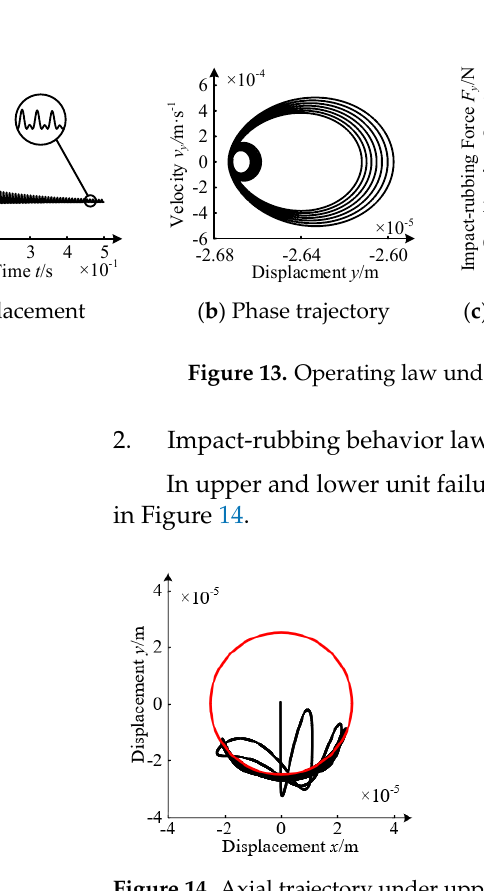
Similarly, the rotor displacement, phase trajectory, rubbing force, and electromag-